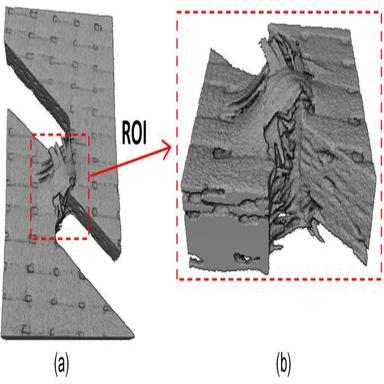
Reconstruction model: (a) Reconstruction model of shear sample; (b) Reconstruction model of shear area.